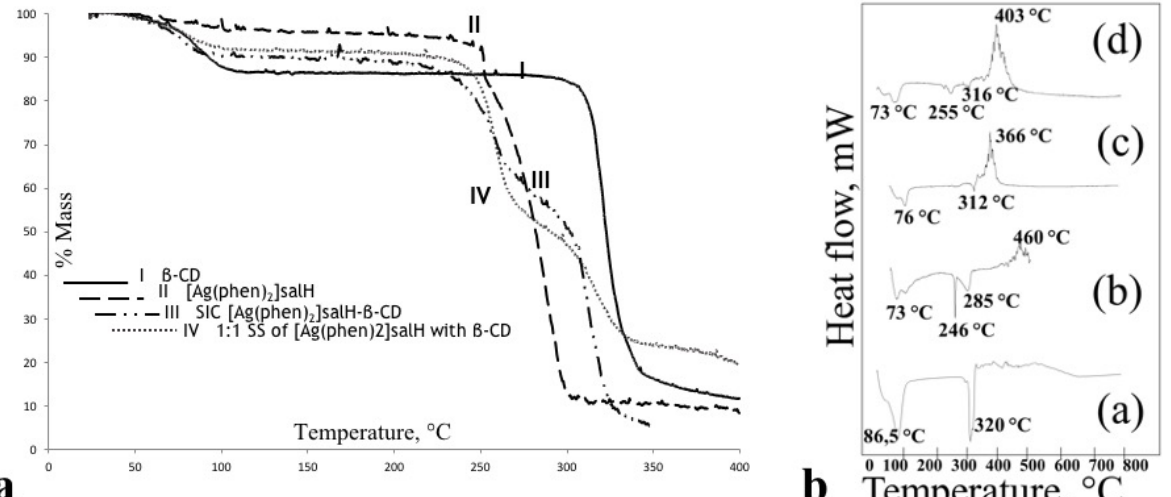
Figure 3. a - TGA results of β-CD (I), [Ag(phen) salH-β-CD (IV). b - DSC results of β-CD (a), [Ag(phen) [Ag(phen) ]salH with β-CD (d). The amount of sample used was 2.5 mg, in an alumina capsule and in a dynamic 2 atmosphere of nitrogen. The heating rate was 10 °C min -1